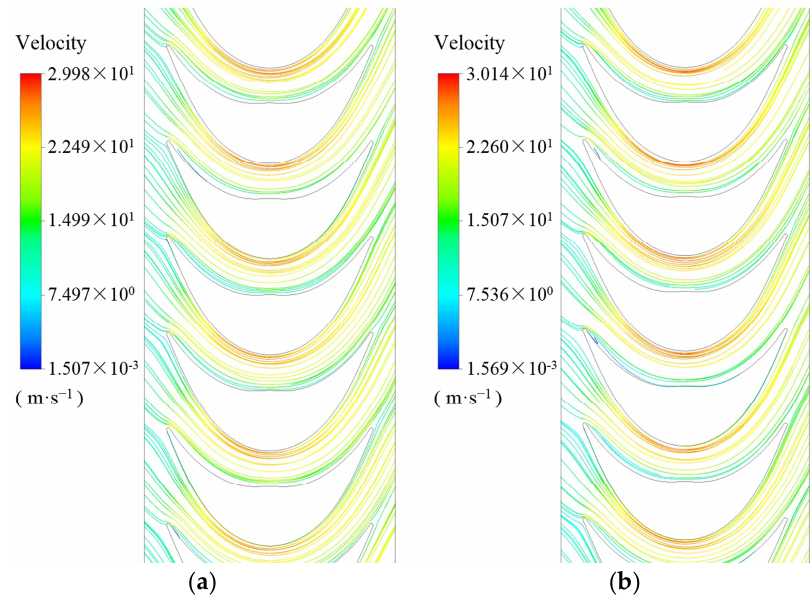
Figure 8. Flow pattern for ( a ) airfoil type vane and ( b ) plate type vane. φ =